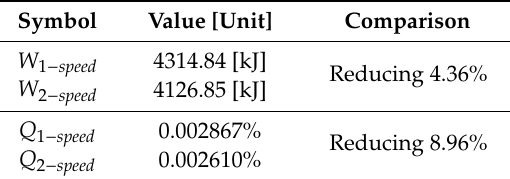
Figure 15. Simulation results of battery capacity loss percentage and energy consumption under UDDS conditions. Table 8. Simulation results of different gearboxes under Urban Dynamometer Driving Schedule (UDDS) conditions.